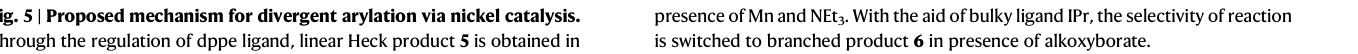
Fig. 5 | Proposed mechanism for divergent arylation via nickel catalysis. Through the regulation of dppe ligand, linear Heck product 5 is obtained in